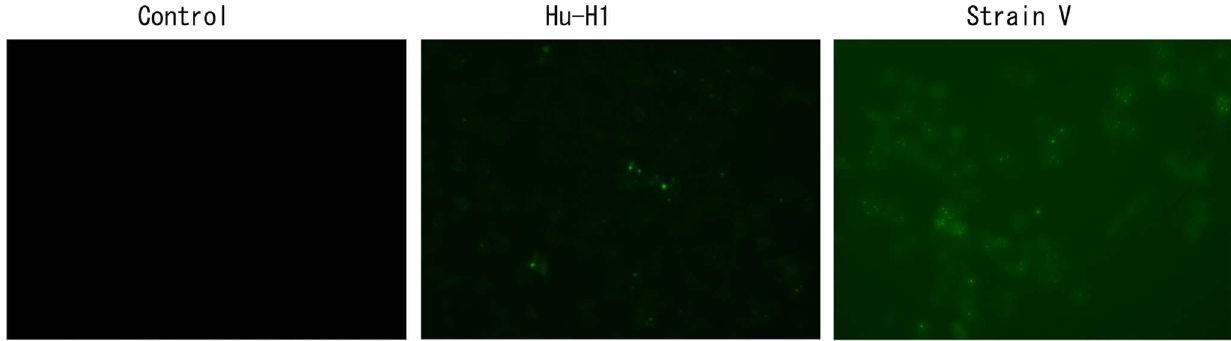
Figure 1. p40 expression on day three post-infection in Hu-H1 and Strain V cells.